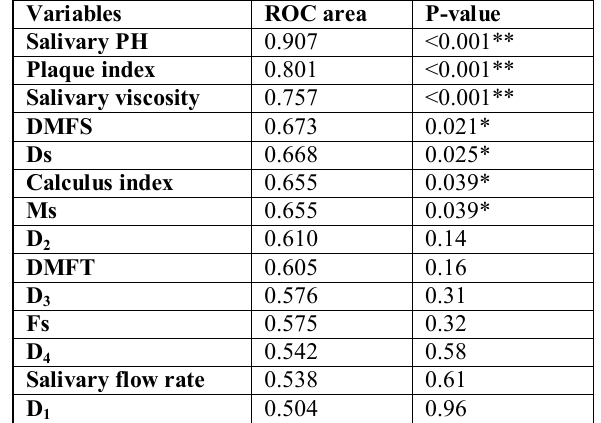
Table 6: Effect of pregnancy on oral variables (ROC test). Variables